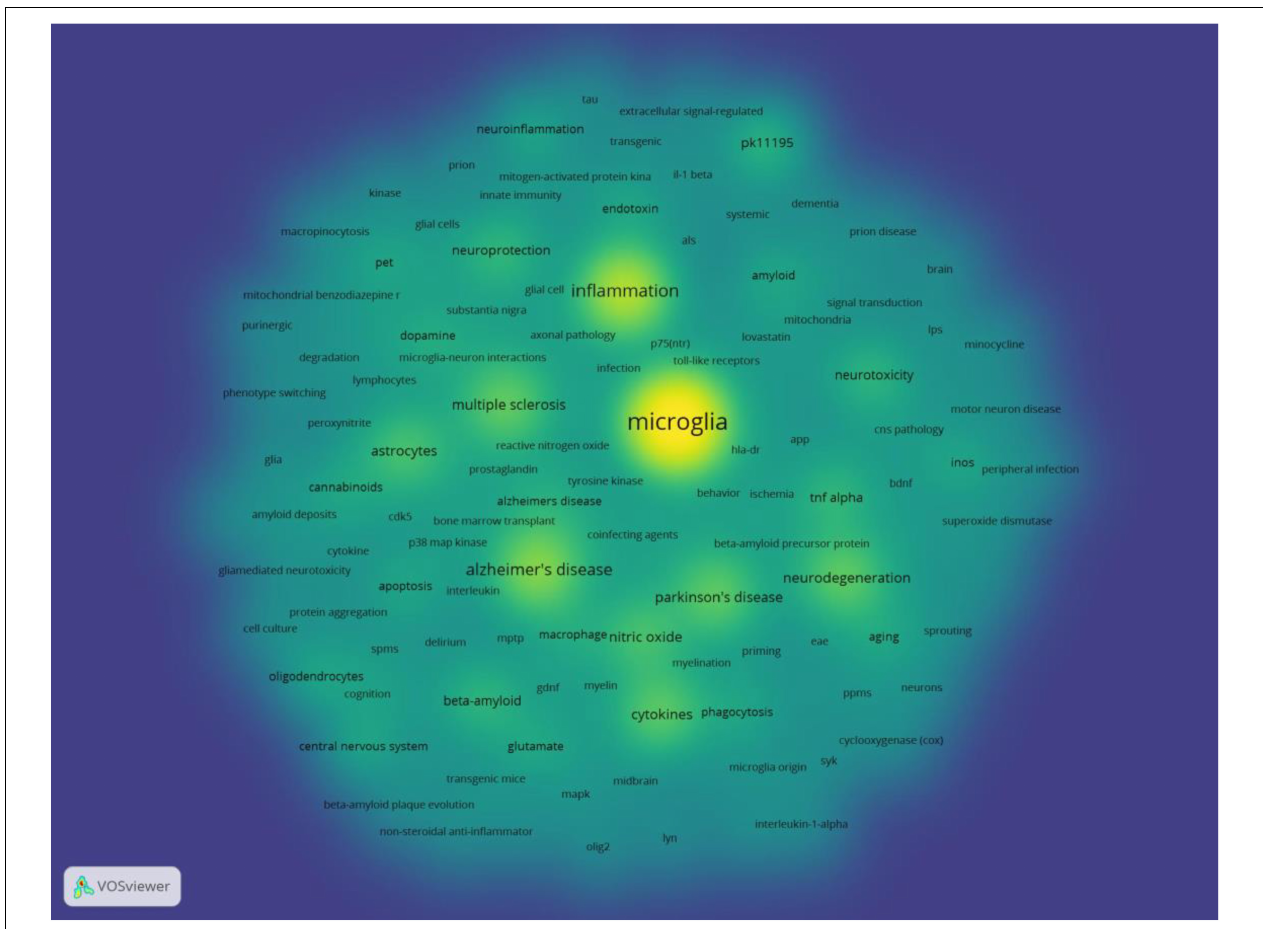
FIGURE 12 | Co-occurrence analysis of frequently occurred author keywords, weighed by occurrence, density